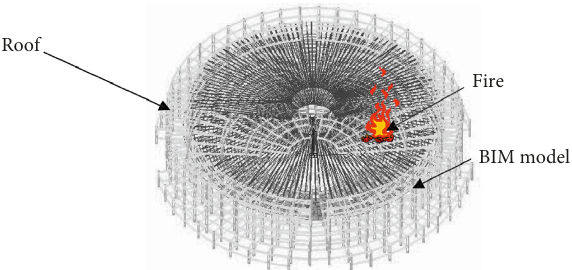
Figure 22: The building model and plan.